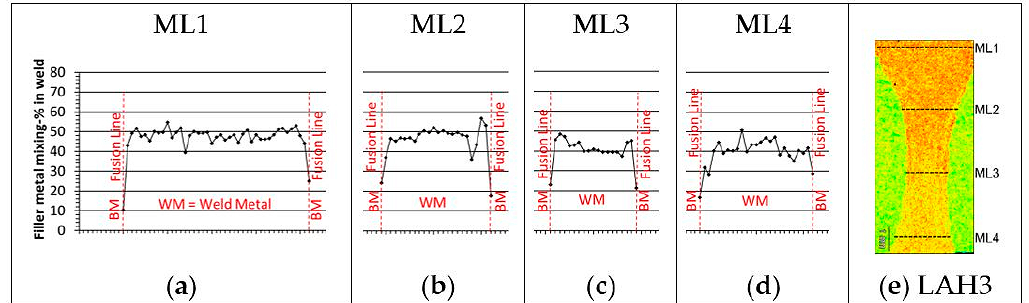
Figure 11. Filler metal mixing results from EDS stepwise characterization. ( a – d ) Filler metal mixing-% profiles of measurement lines 1–4 (ML1–ML4) from test weld LAH3 ( e ). In figures ( a – d ) one step between adjacent measurement points in the horizontal axis equals 100 micrometres.